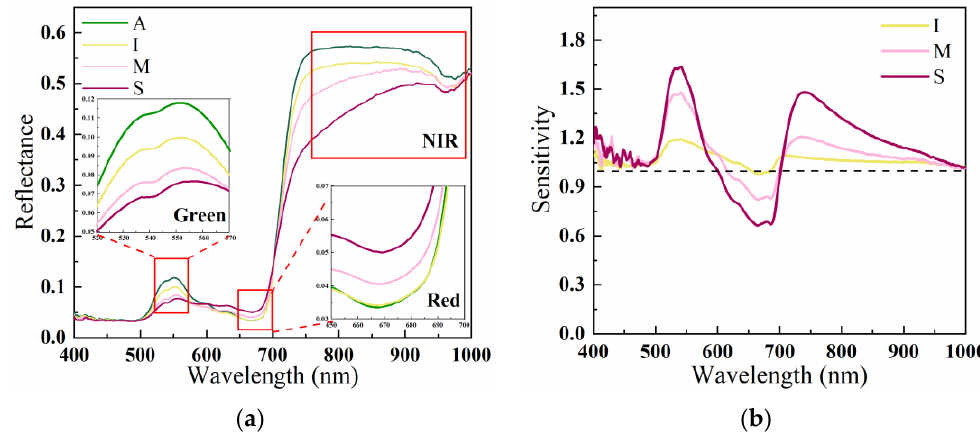
Figure 3. Average reflectance and sensitivity for different leaf spot disease levels. ( a ) Average reflectance, ( b ) sensitivity.